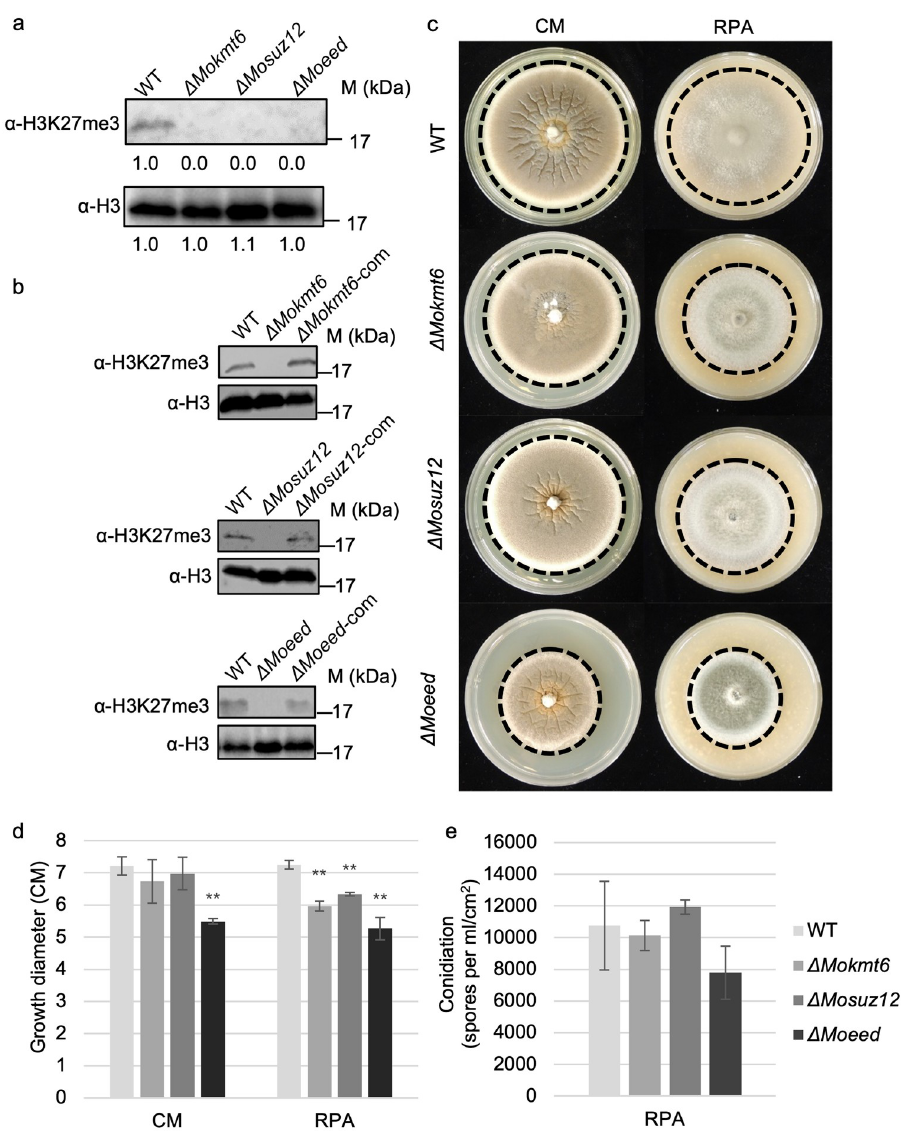
Fig 2. PRC2 mediated H3K27me3 is required for normal fungal in vitro growth. (A) Total proteins extracted from wild type (WT), Δ Mokmt6 , Δ Mosuz12 and Δ Moeed were used for western blotting. The anti-H3K27me3 was used for detecting the global level of H3K27me3 in the samples and anti-H3 was used as loading control. Intensity of signals were analyzed by ImageJ. (B) Total proteins extracted from wild type, Δ Mokmt6 , Δ Mosuz12 , Δ Moeed , Δ Mokmt6-com , Δ Mosuz12-com and Δ Moeed-com were subjected to western blotting. (C) Colony morphology of wild type, Δ Mokmt6 , Δ Mosuz12 and Δ Moeed on the complete medium agar (CM) and rice polish agar (RPA) at 12 days post inoculation. Dotted lines highlighted the edge of colonies. (D) Colony diameters were measured at 12 days post inoculation and subjected to statistical analysis. Significance is present by double asterisks ( p < 0.01) or single asterisk ( p < 0.05) to indicate significant differences compared with wild type by student’s t-test. (E) Production of asexual conidia in different strains were measured after culturing on rice polish agar at 10 days post inoculation under constant light.